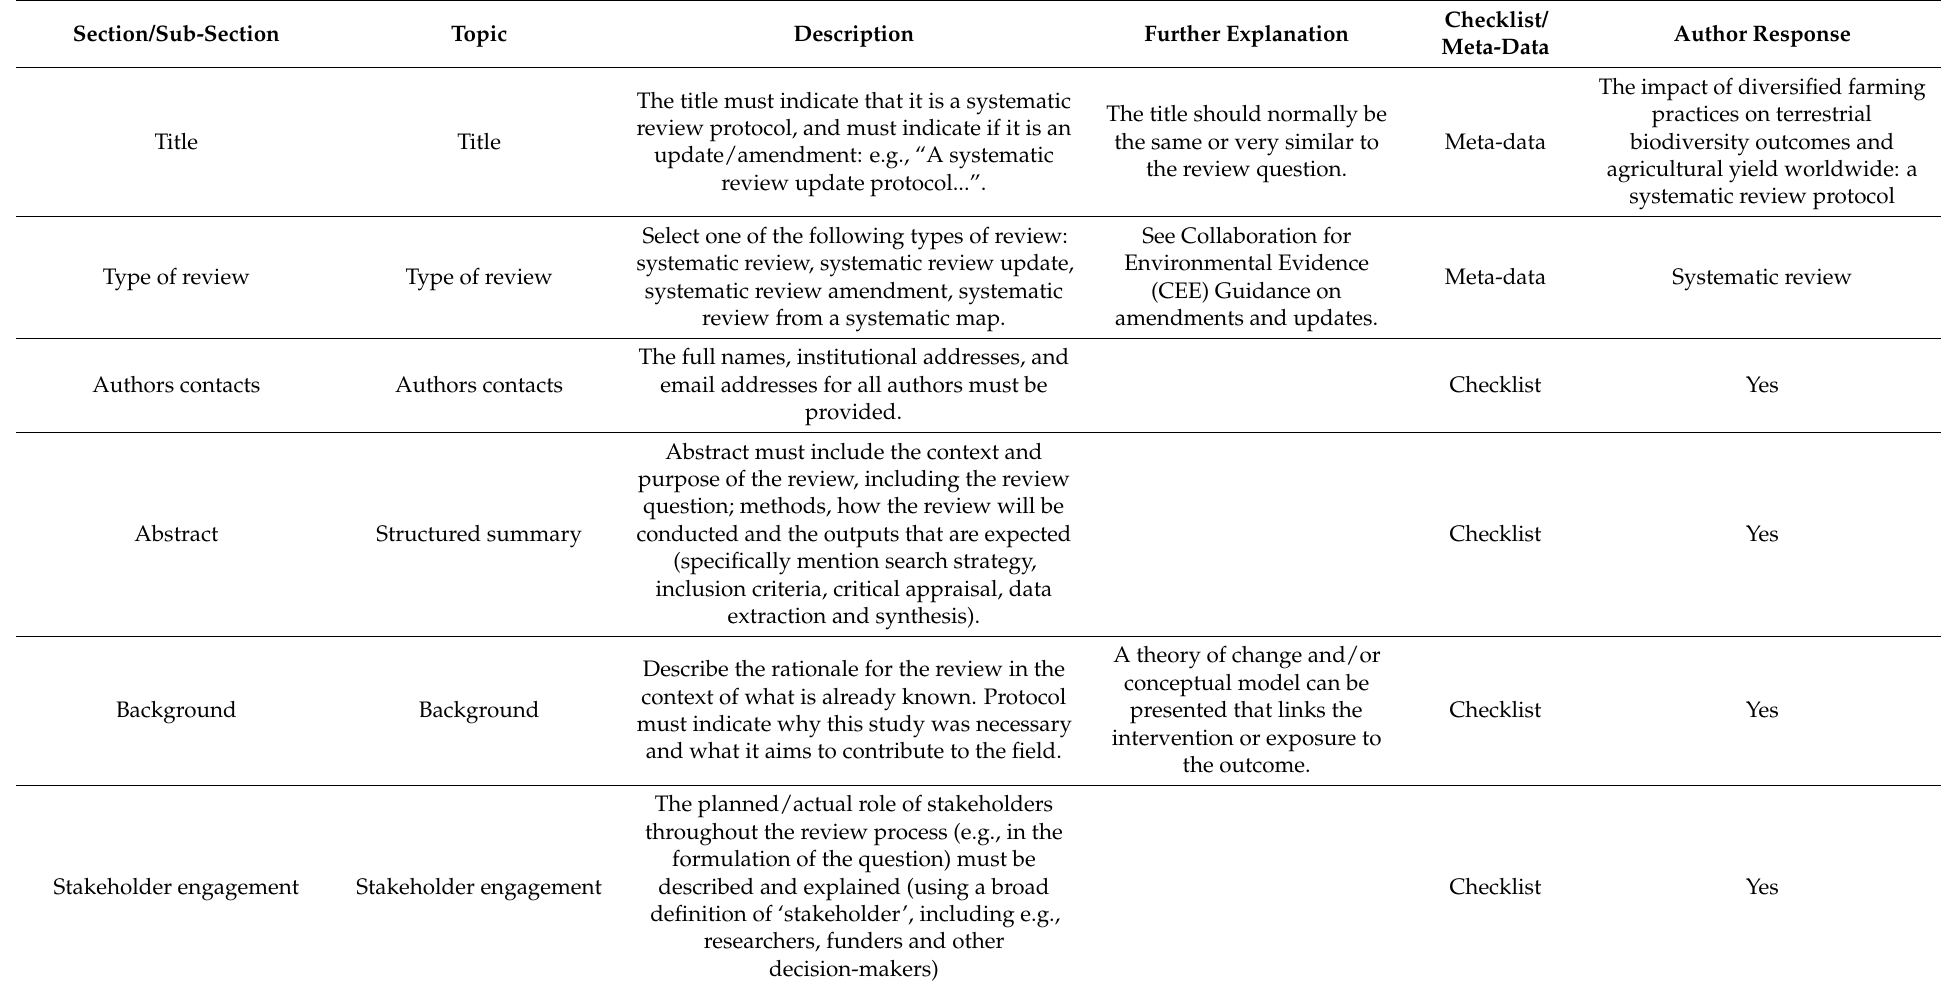
Table A1. ROSES form for systematic review protocols. Version 1.0 (Haddaway et al.,